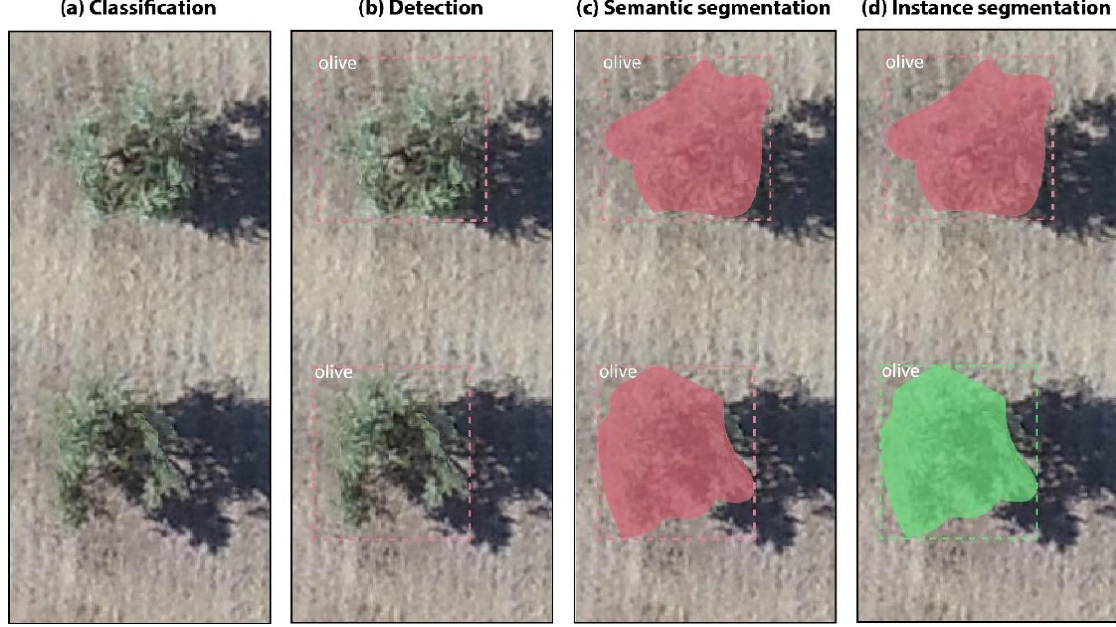
Figure 1. Illustration of the four fundamental computer vision tasks in the problem of olive-tree monitoring: ( a ) Image classification, ( b ) Object detection, ( c ) Semantic segmentation and ( d ) Instance segmentation.